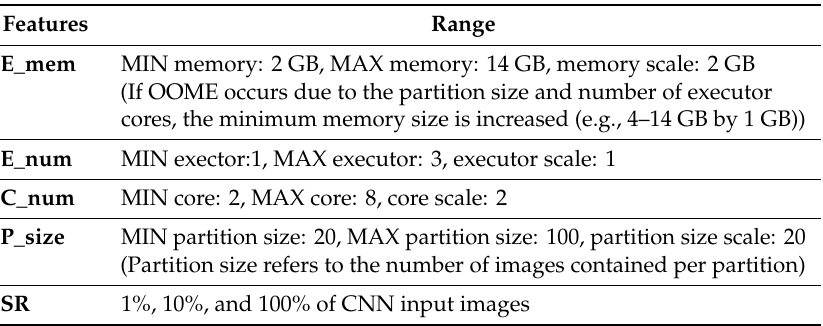
Table 9. Values of the features for Spark CNN.